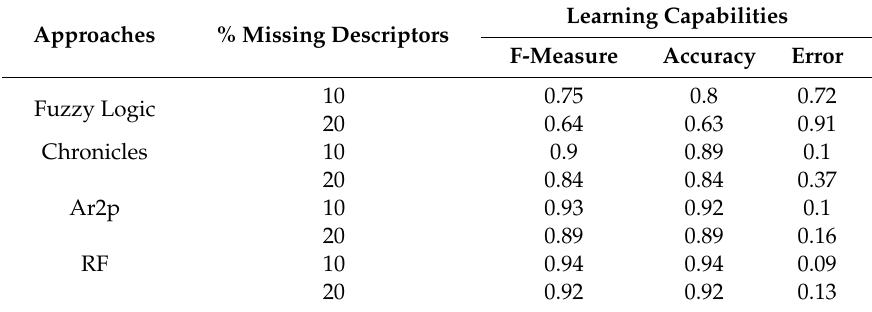
Table 14. Results of the Learning Capabilities with missing descriptors during the testing phase. Approaches